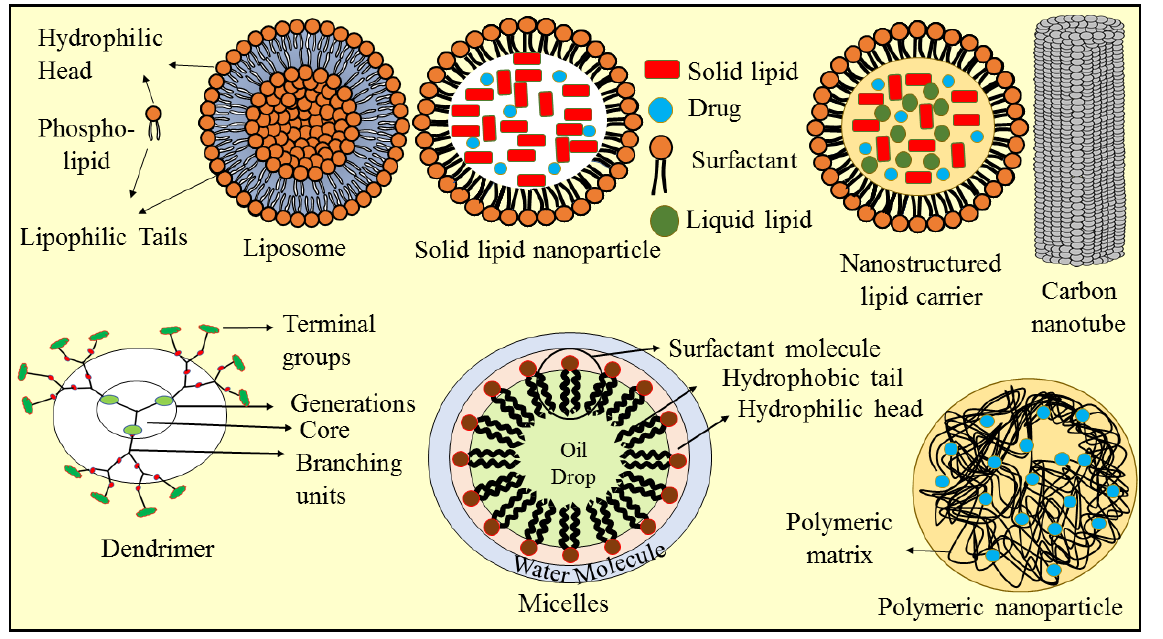
Figure 3. The structural representation of various types of nanocarriers explored for encapsulation of berberine molecules to overcome its therapeutic